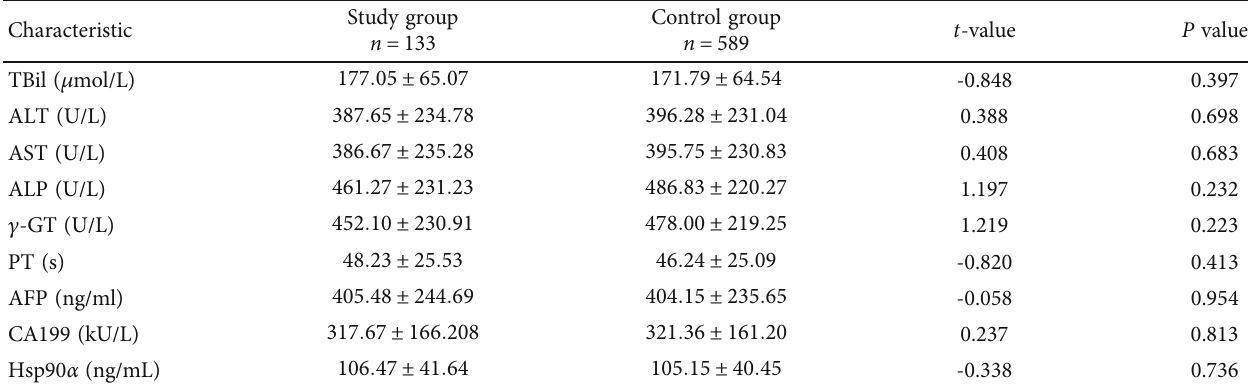
Table 2: Baseline characteristics of laboratory results ( mean ± SD ).